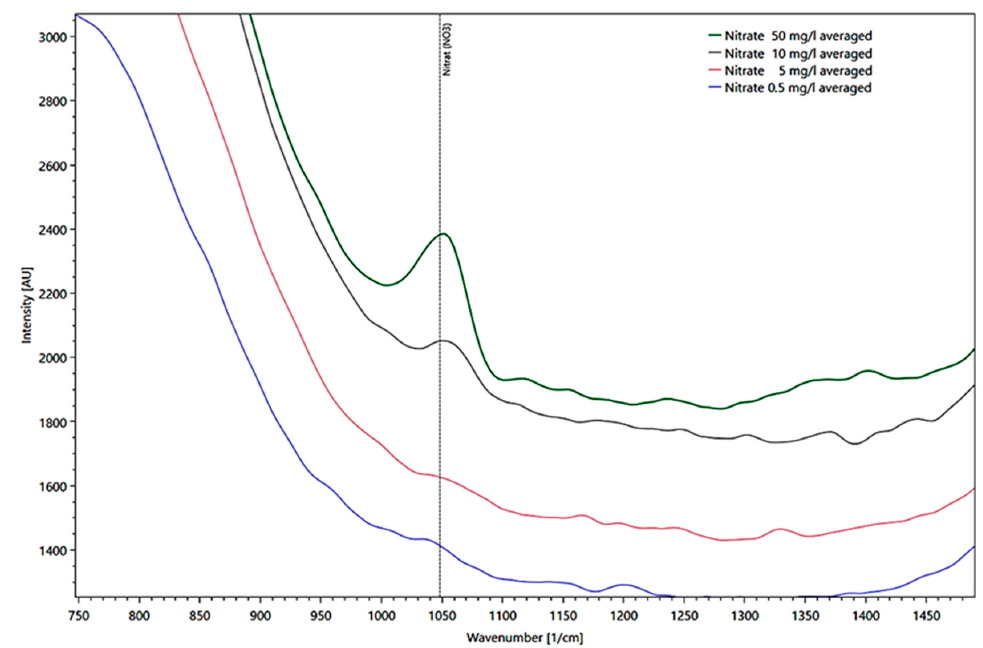
Figure 8. Presentation of different water peaks corrected for nitrate average concentrations from 50 (green line), 10 (black line), 5 (red line), to 0.5 mg/l (blue line) derived from their intensities as Raman spectra, measured in a fused silica cuvette.